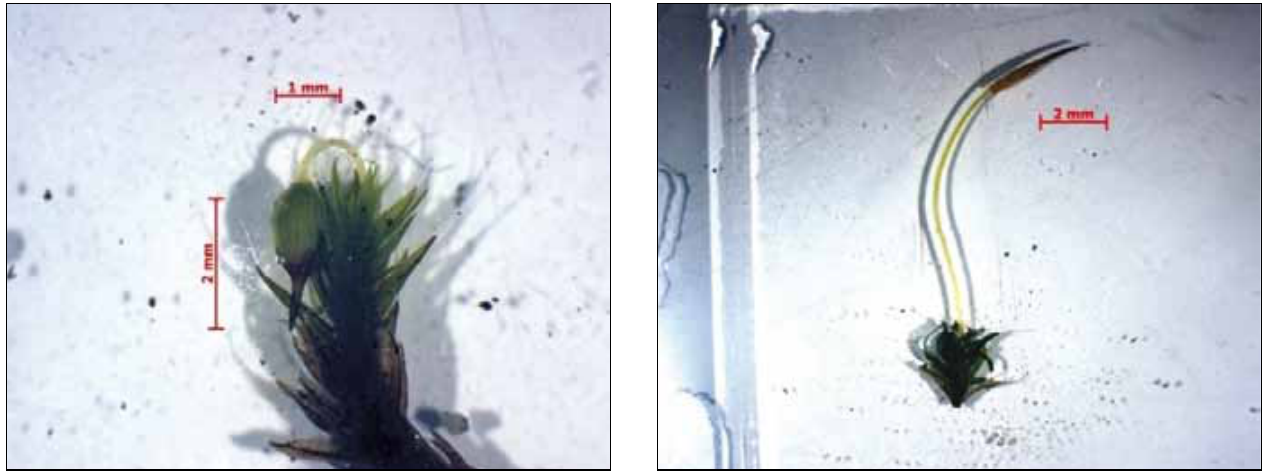
Figure 1. Grimmia pulvinata (left) and Barbula unguiculata (right) (photos by F ülöp -p ocsai , 2014) Table 1. Collected moss species